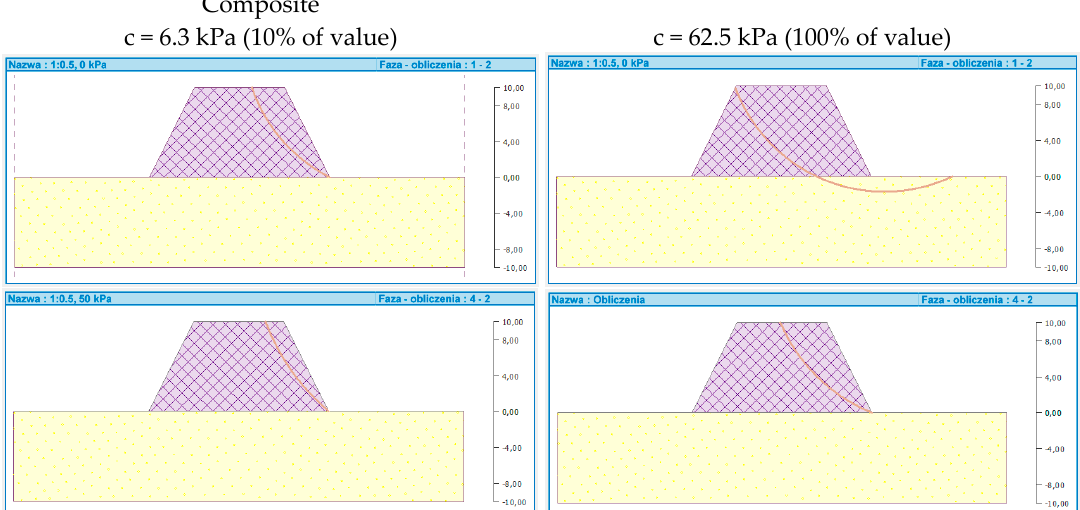
Figure 8. Slip surface at different load and cohesion values when the inclination was 1:0.5. Increasing the load on the road embankment from 0 to 50 kPa resulted in a decrease in the factor of safety from about 14 to 39% (Figure 9) (adequately when cohesion was 10% of its test value and